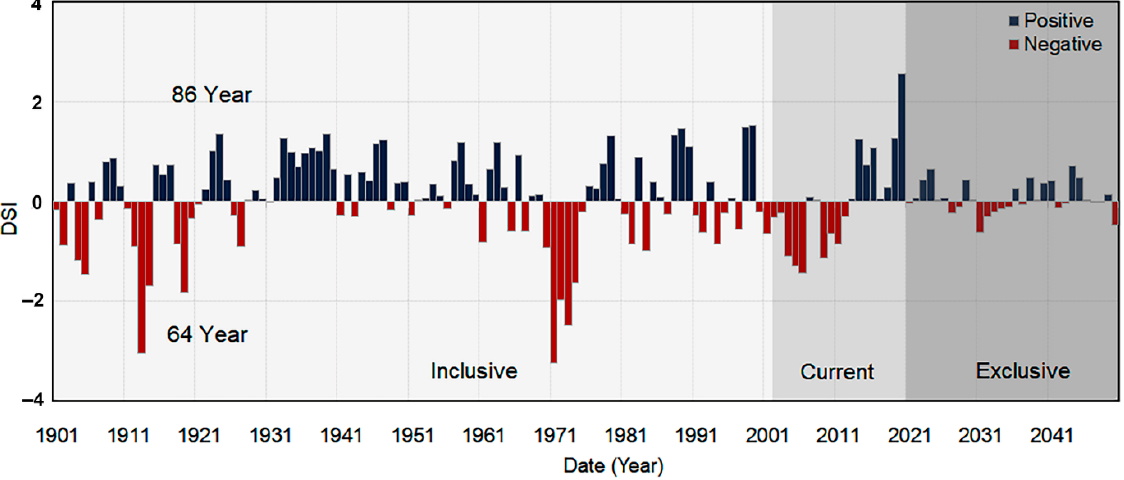
Figure 13. The dry and wet months in the NRB between 1901 to 2050.